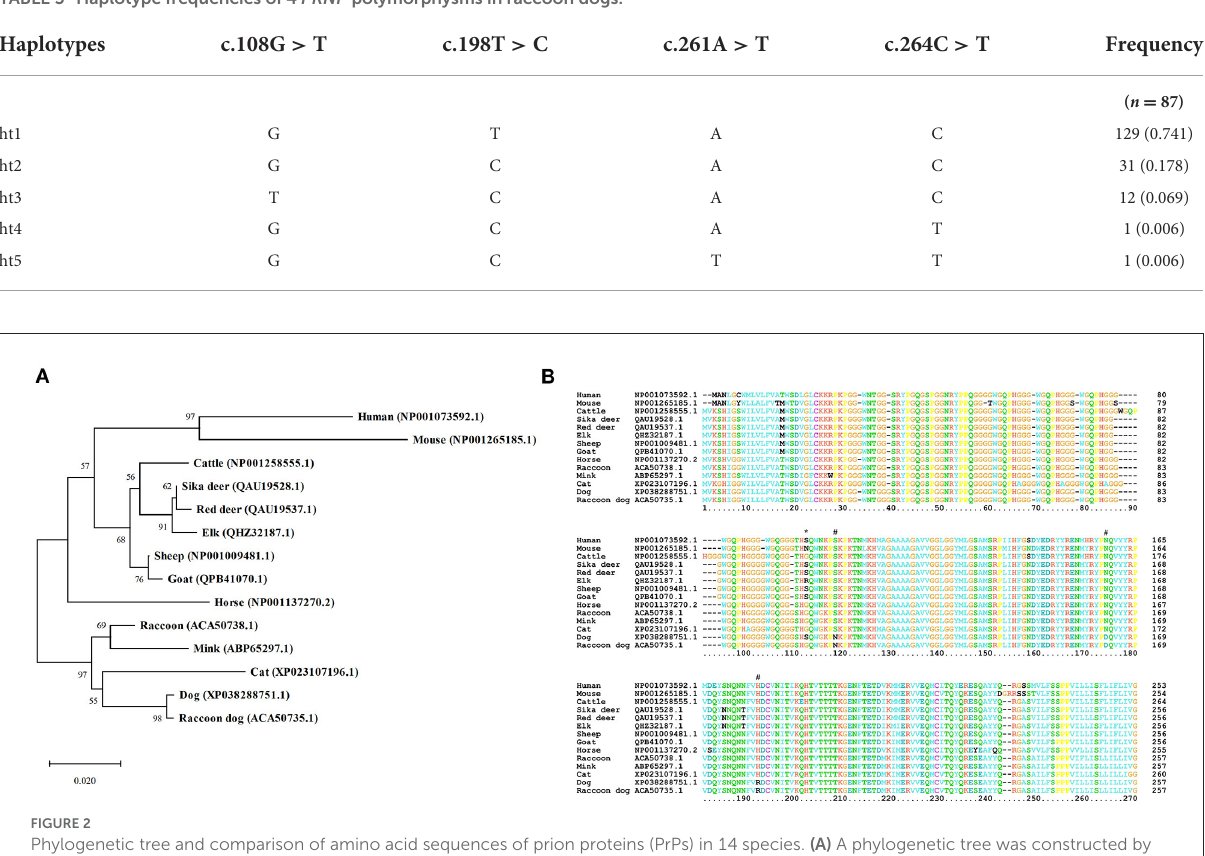
TABLE 3 Haplotype frequencies of 4 PRNP polymorphysms in raccoon dogs.